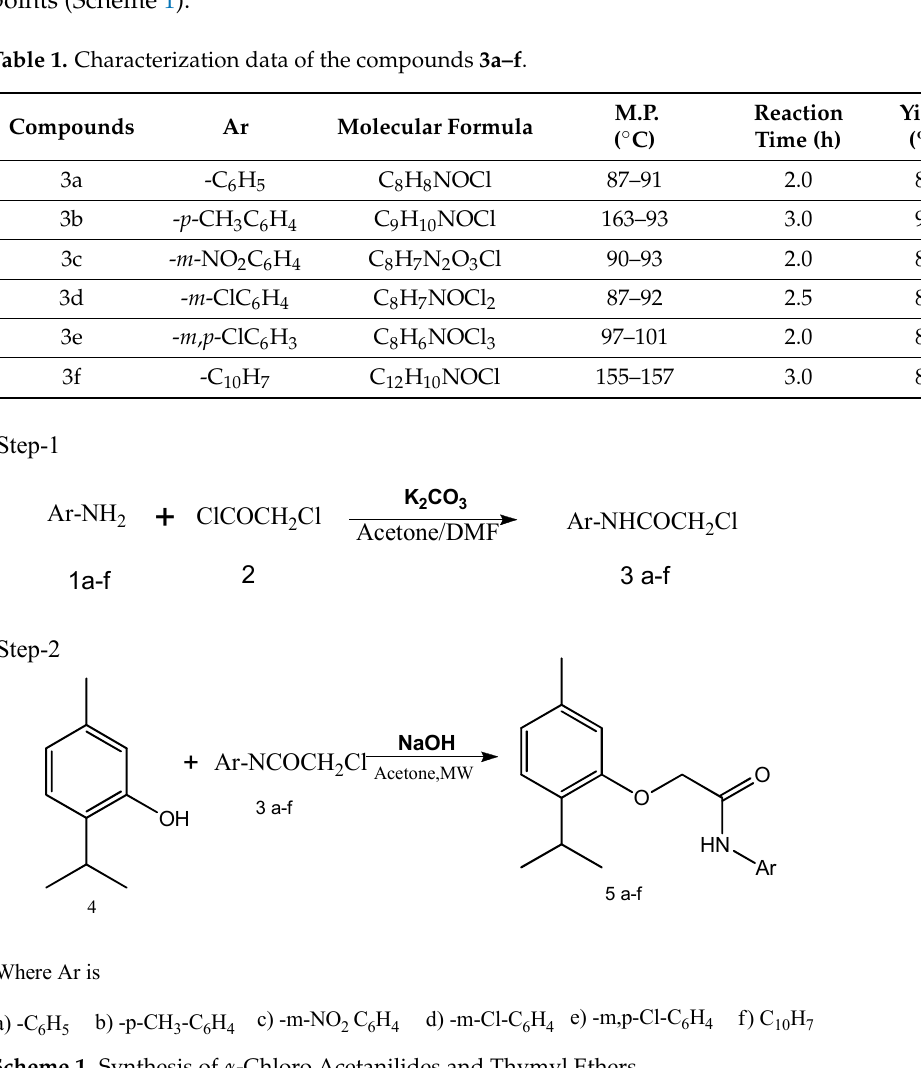
Table 1. Characterization data of the compounds 3a–f . Compounds Ar Molecular Formula